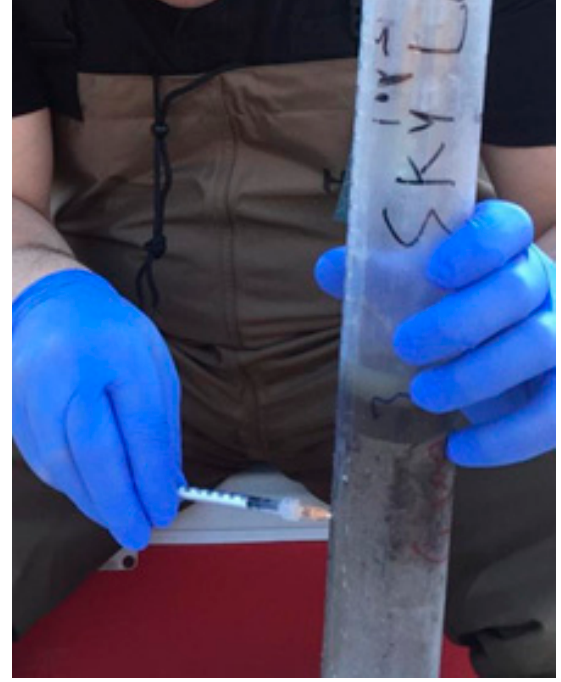
Figure 4. Injecting Hg tracer isotopes into a sediment core. Two (duplicate) sediment cores were taken at each sample site. Stable isotope spike so- lutions of 200 Hg 2+ and 199 CH 3 Hg + were prepared at concentrations ranging from ~10–100% of ambient concentrations by diluting the standard with bottom water from the site. The mixture was left to equilibrate for an hour prior to usage to attain natural condi- tions/speciation [18]. Approximately 0.2 mL of spike solution was injected into each 1 cm increment down to approximately 20 cm (Figure 4). After spiking, the sediment cores were placed back into the wetland and open water sites to incubate for 2 h before